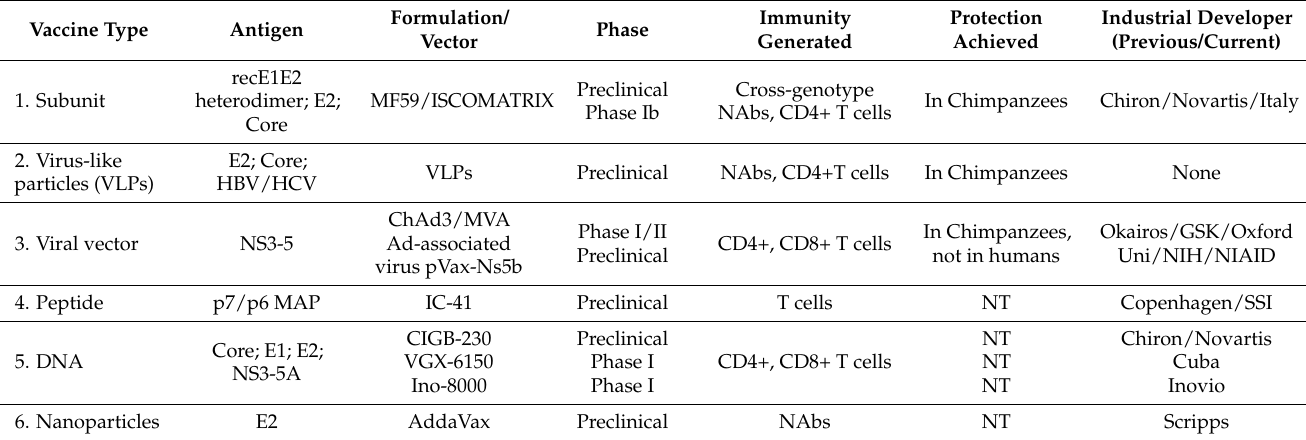
Table 1. Examples of vaccines in development for hepatitis C virus